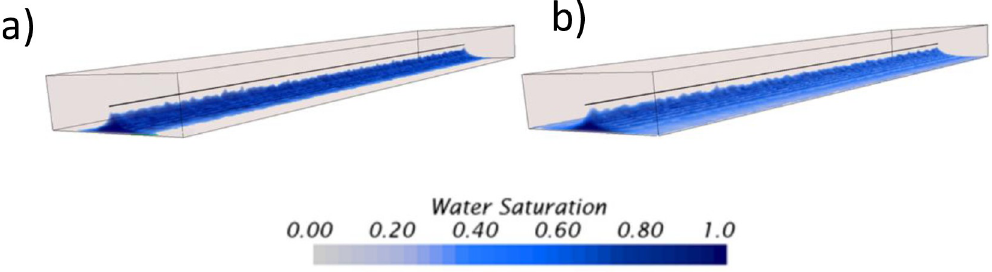
Fig 10. Dynamics of the water movement near the wellbore for the S wi sensitivity analysis, a) at S wi = 0%, b) at S wi = 40%. 3D renders taken at the breakthrough time.